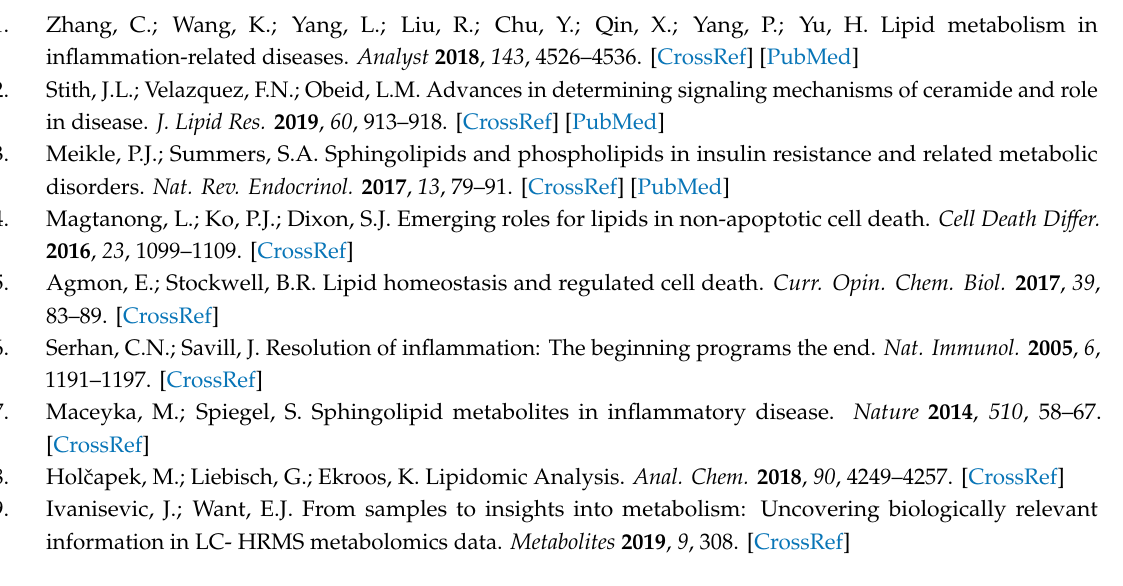
Figure S1: Extracted ion chromatograms of m / z values corresponding to precursor ions of standard phospholipids containing two palmitoyl moieties, Figure S2: MN of PS subclass, Figure S3: MN in PI subclass, Figure